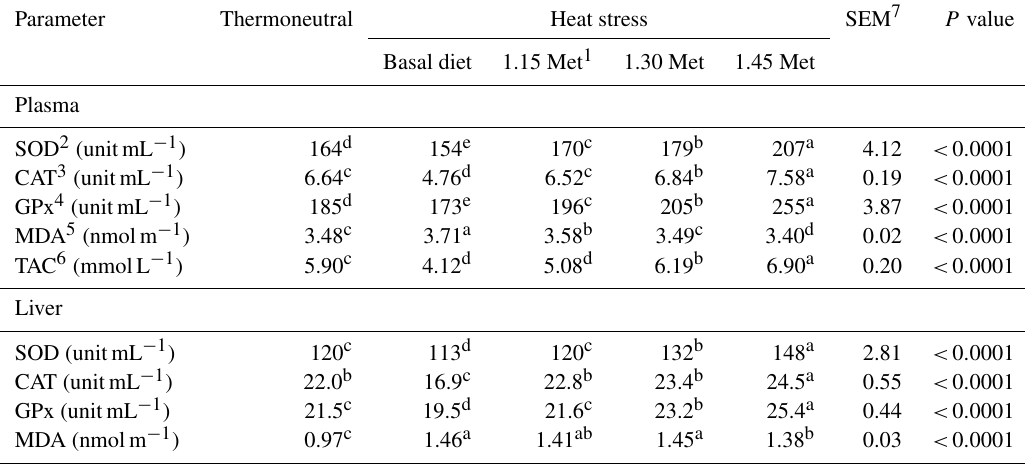
Table 8. Effect of methionine on antioxidant parameters and malondialdehyde in the plasma and liver of breeder quails. Parameter